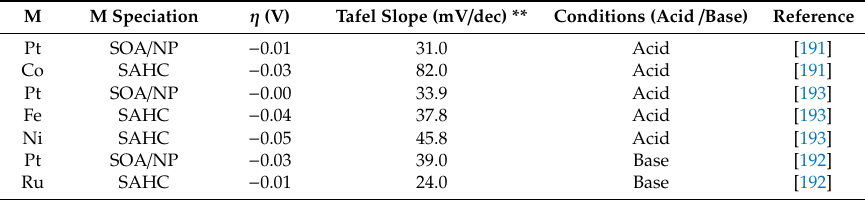
Table 2. Comparison of experimentally measured kinetic and thermodynamic parameters of recently developed carbon-supported HER SACs in comparison to state-of-the-art Pt systems.